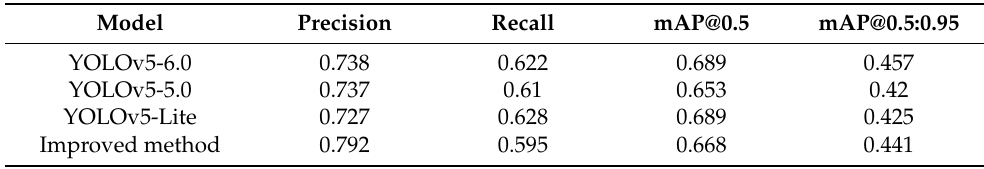
Figure 11. Representative images showing the training process of the improved method. Table 8. Comparison of test results of YOLOv5-6.0, YOLOv5-5.0, YOLOv5-Lite, and improved methods using Pascal VOC2007 public